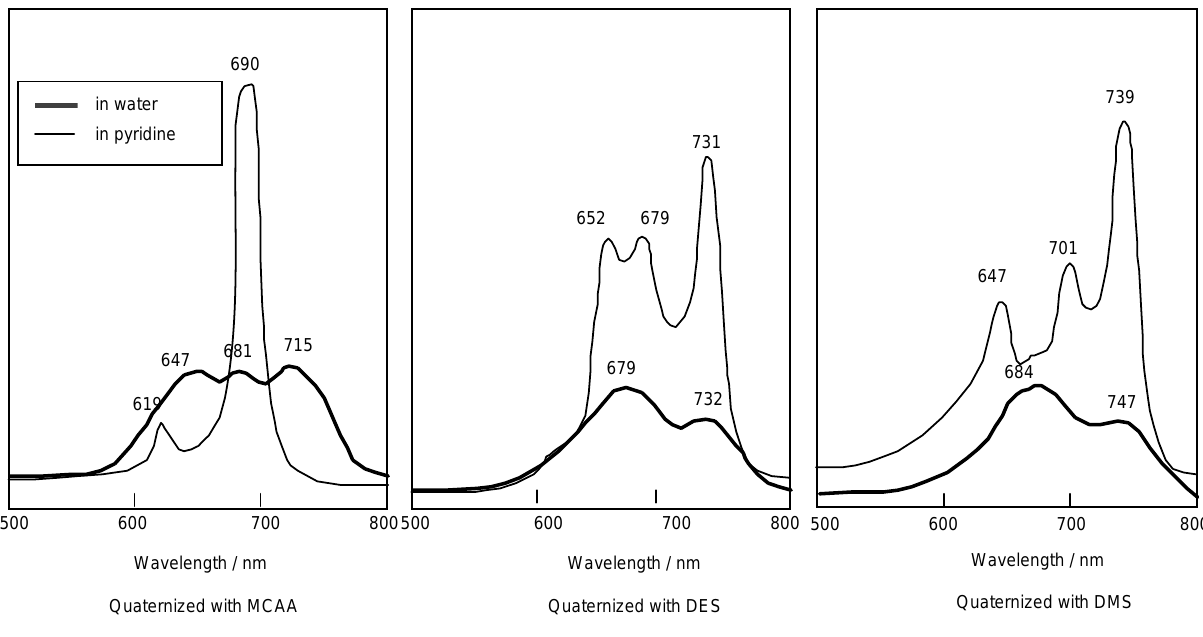
Figure 3. UV-Vis spectra of 5c quaternized with MCAA, DES and DMS. The UV-Vis spectra of each quaternized compound was measured in pyridine solution or